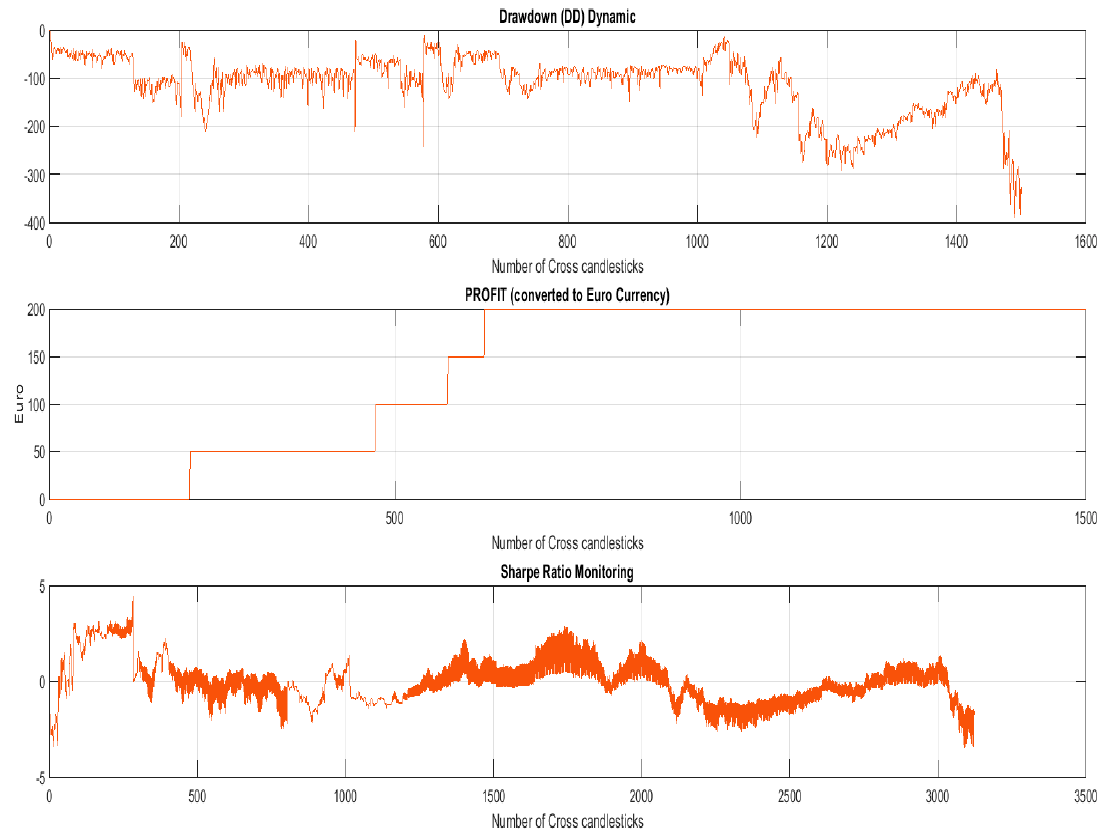
Table 4. Trading Performance Comparison